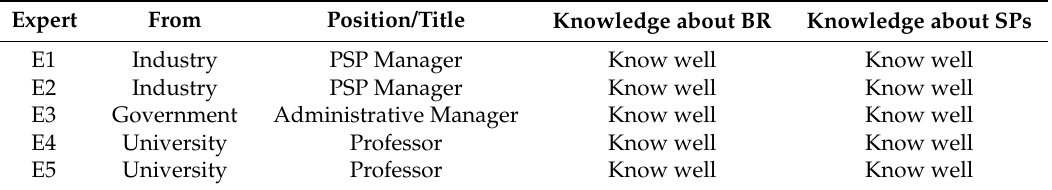
Table 2. Information of